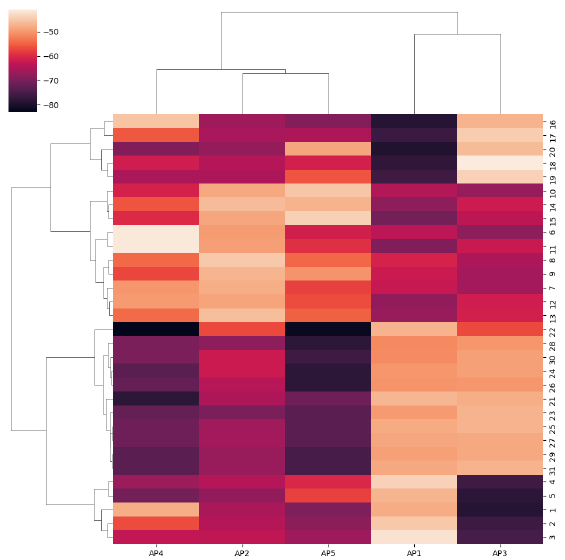
Figure 4. Positioning trajectory diagram of different